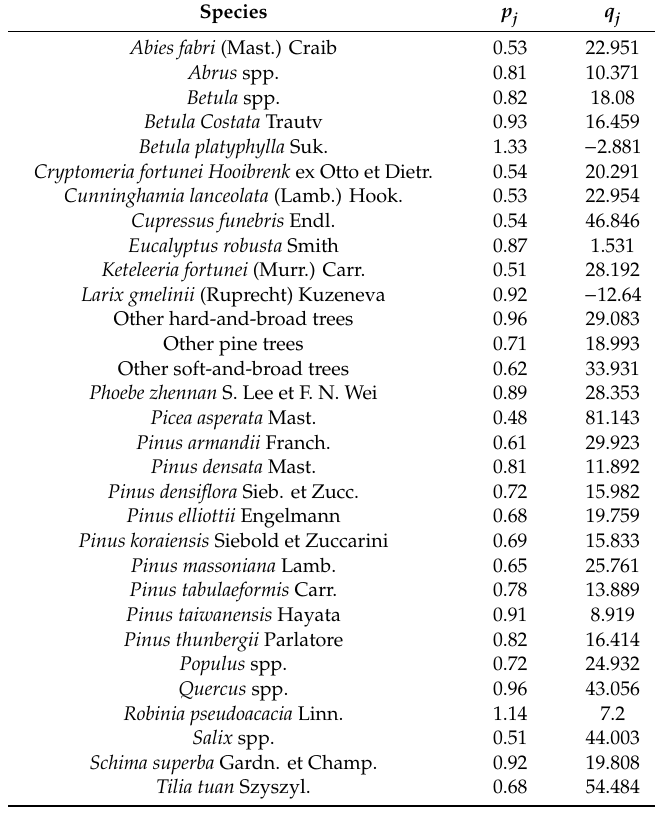
Table 2. The conversion relations between stand volume and aboveground biomass